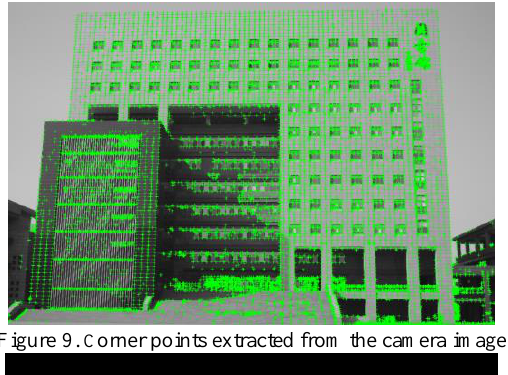
Figure 9. C orner points extracted from the camera image